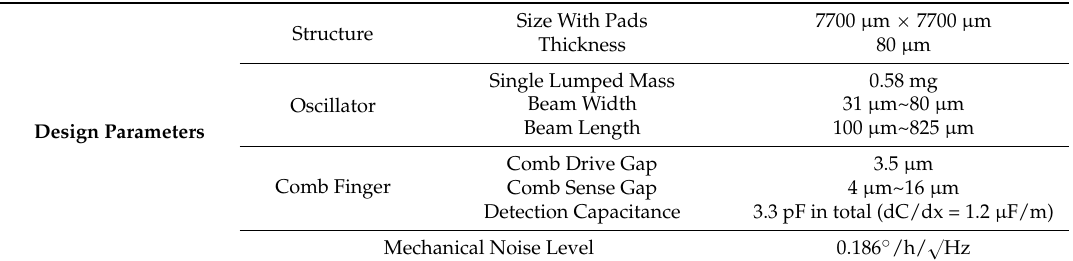
Table 4. Design parameters of the CSQMG.